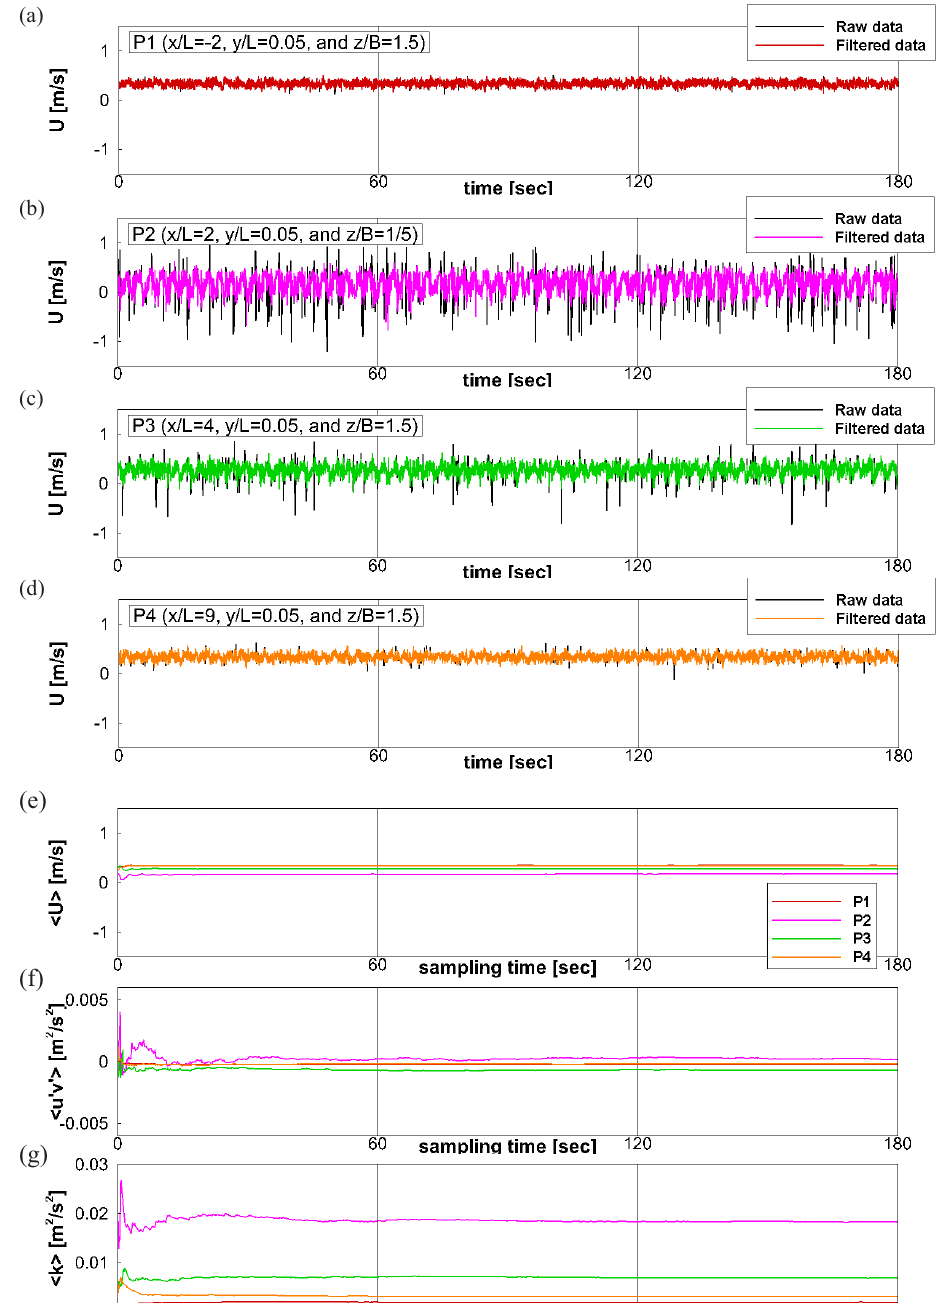
Figure 3. ( a – d ) Streamwise velocity time series before and after the postprocessing of the velocity measurements. Temporal convergence study: ( e ) the streamwise velocity, ( f ) the primary Reynolds shear stress, and ( g ) the turbulence kinetic energy averaged over progressively increasing sampling times. P1, P2, P3, and P4 are defined by x / L = − 2,2,4, and 9 at invariant y / L = 0.05 (nearest point to the lateral side wall) and z / B = 1.5 (at the turbine center